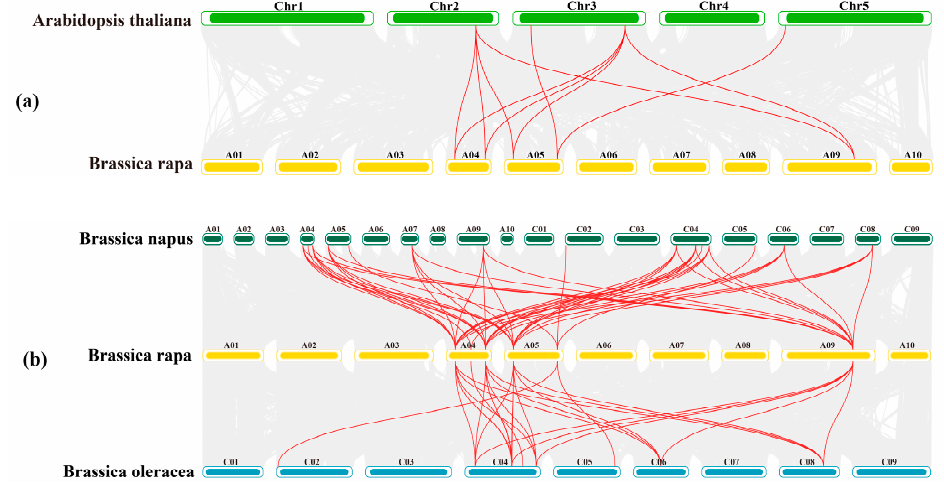
Figure 4. ( a ) Collinearity analysis between Brassica rapa and Arabidopsis , the gray line in the background indicates the collinear block in the genomes of Brassica rapa and Arabidopsis , and the red line highlight the homologous PAL gene pair; ( b ) Brassica rapa , Brassica napu , Brassica oleracea Collinearity analysis of rapeseed, the gray line in the background indicates the collinearity blocks in the genomes of Brassica rapa , Brassica napus and Brassica oleracea , and the red line highlights the homologous PAL gene pairs.